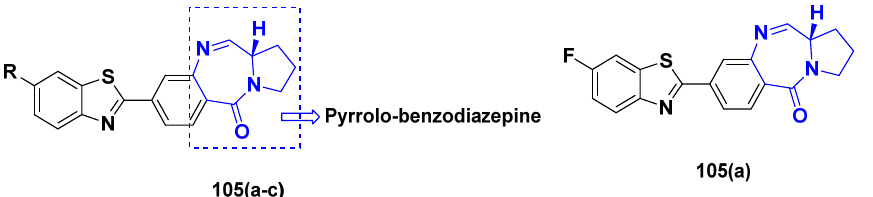
Figure 100. Structure of pyrrolo-benzodiazepine hybrids and the most promising compound 105a . Table 89. In vitro cytotoxic activities of pyrrolo-benzodiazepine hybrid compounds 105 ( a – c ).